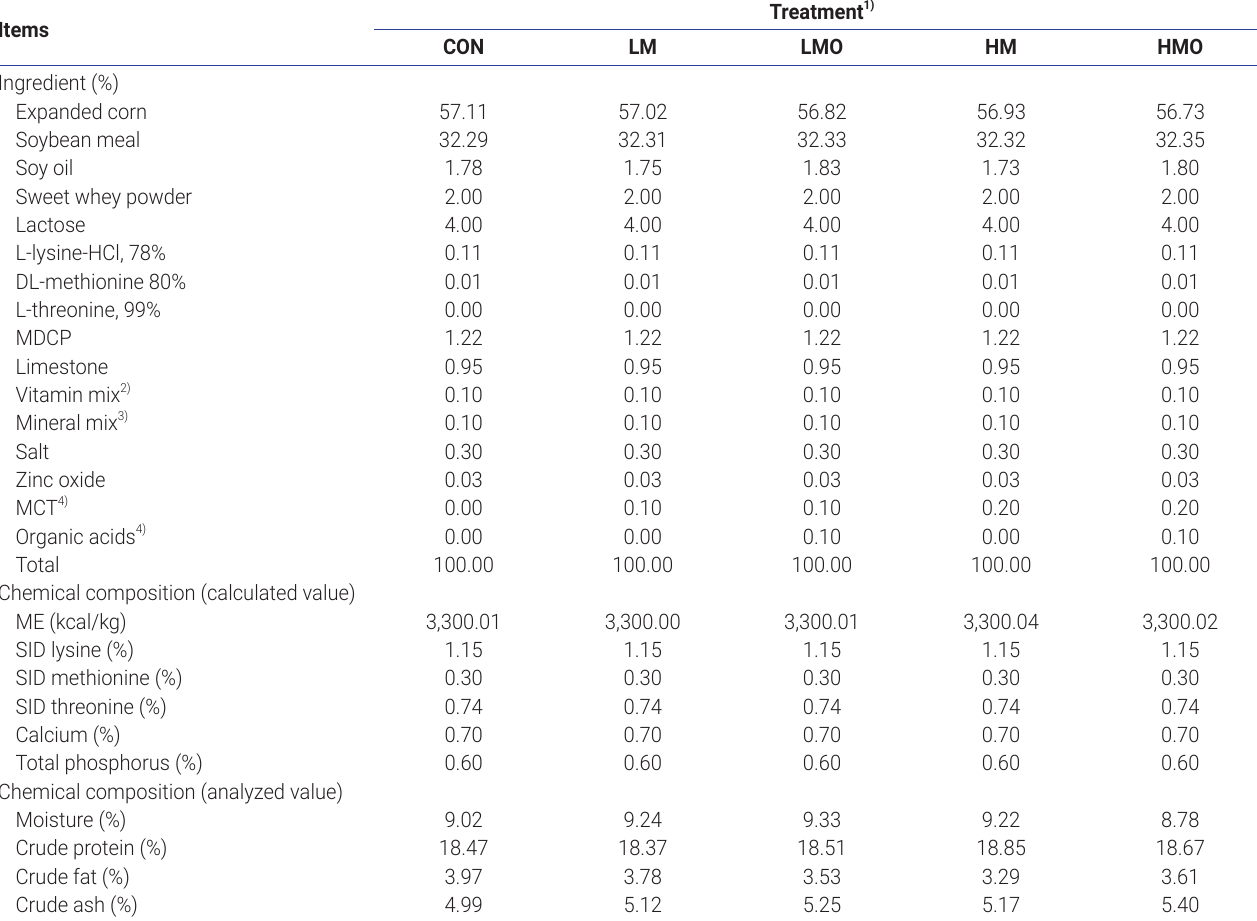
Table 2. Formula and chemical compositions of the experimental diets during the weaning phase 2 (3 to 5